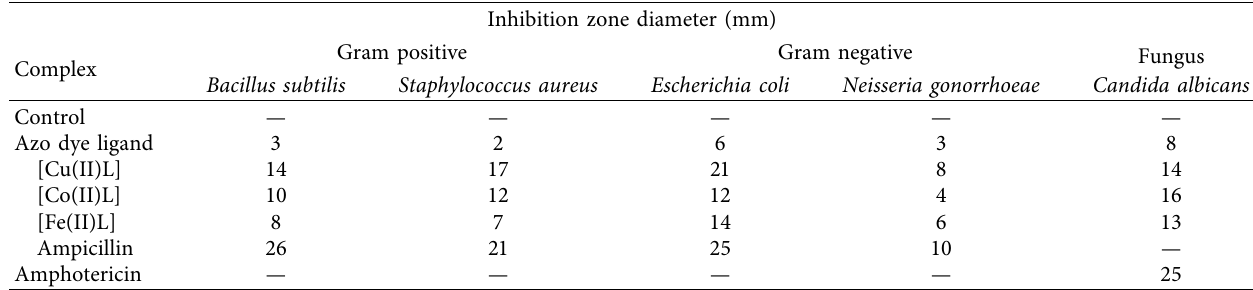
Figure 10: In vitro. (a) Antifungal and (b) antibacterial properties of the azo ligand (HL) and its metal complexes at a concentration of 100 μ L. Table 6: Antibacterial activity data (zone of inhibition in mm) of the ligand and its metal complexes at a concentration of 100 μ